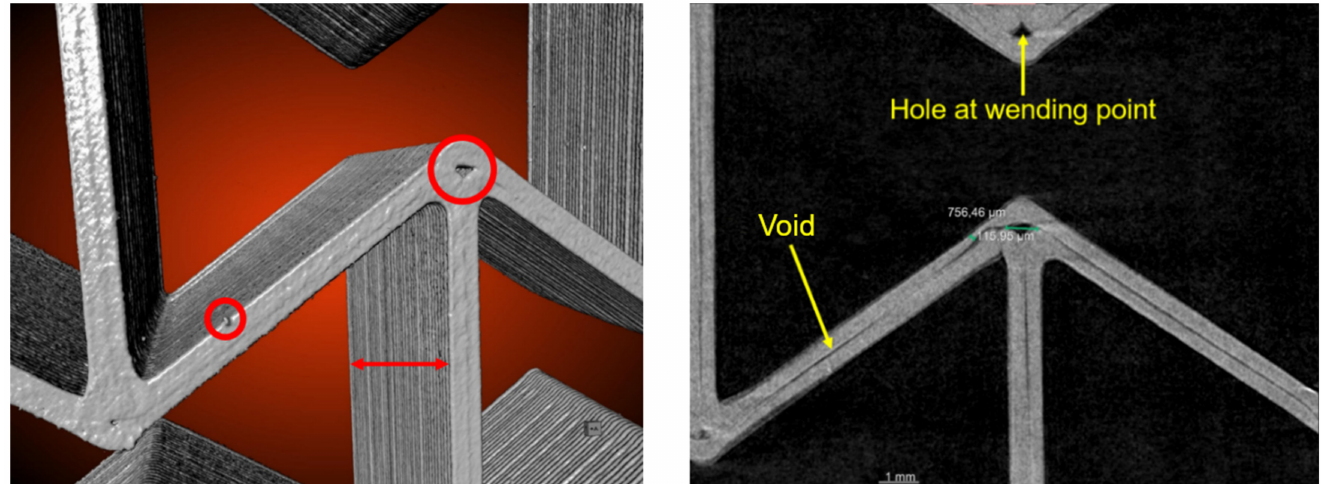
Figure 17. In-situ CT test detected imperfections in a 5 × 5 PLA sample at 0 mm loading (initial) state: bead, throughout holes, ribs ( left ) and local voids ( right ).